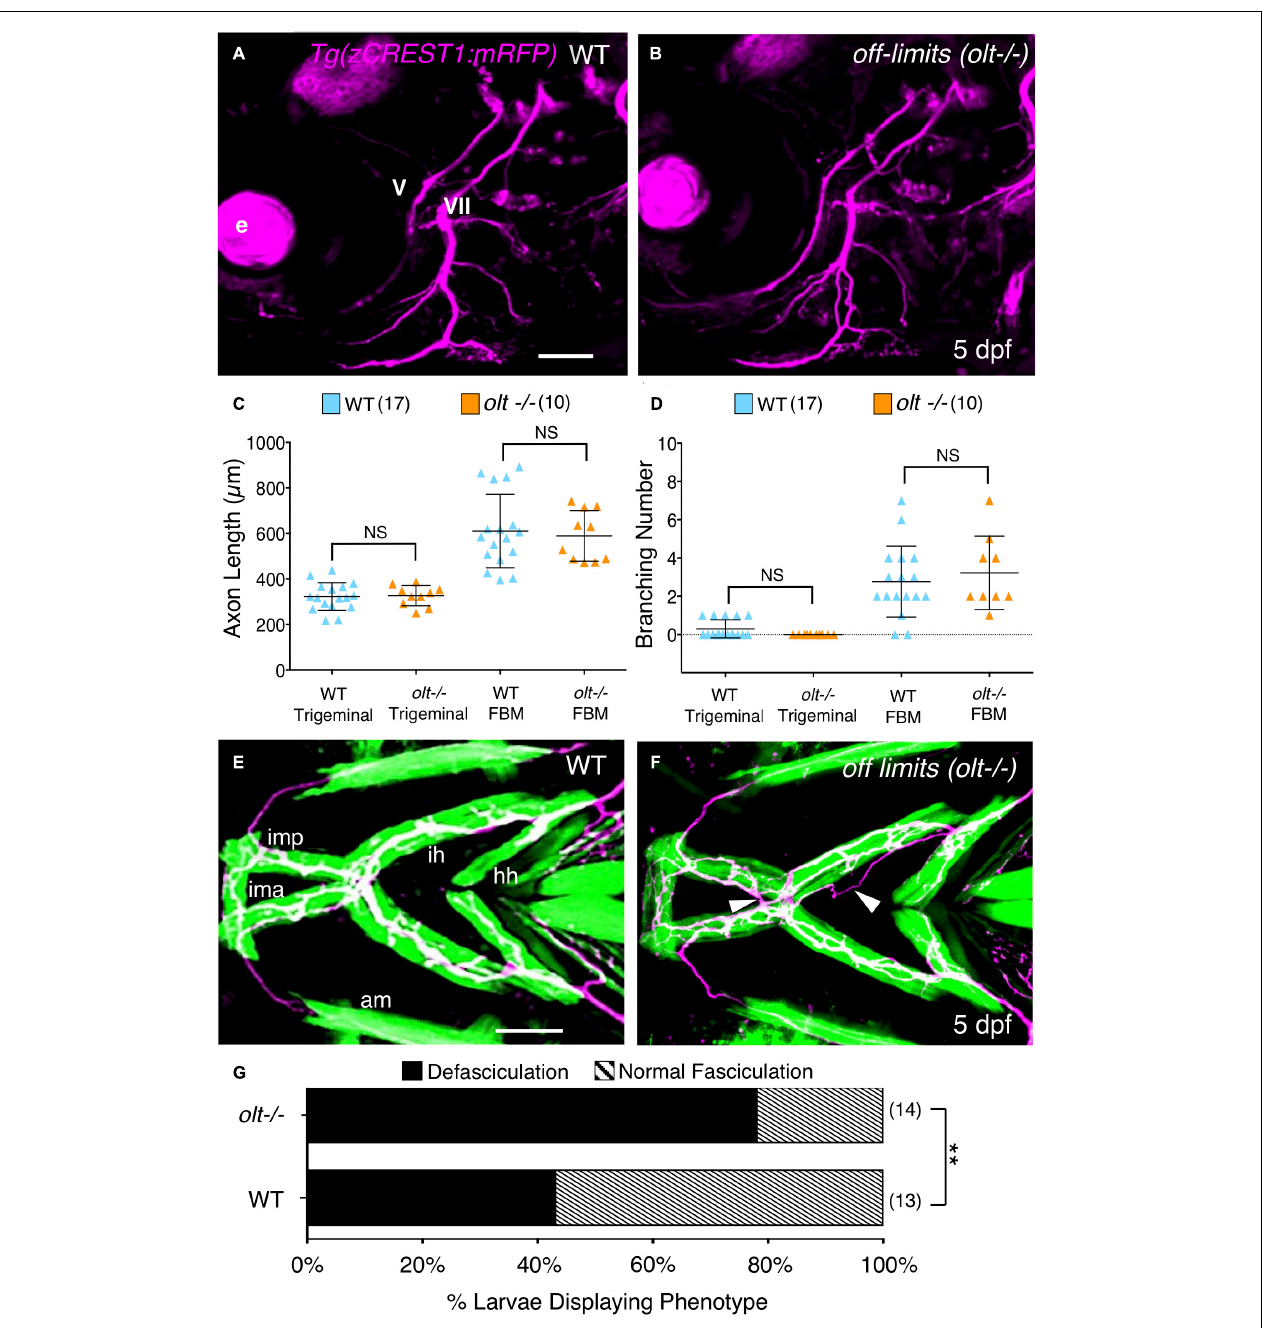
FIGURE 5 | Axon guidance and outgrowth are unaffected in olt mutant larvae. (A,B) Lateral view with anterior to the left of the hindbrains of 5 dpf Tg(zCREST1:mRFP) larvae. The morphologies of trigeminal (V) and FBM (VII) axons were analyzed and number of branches were calculated with Leica Application Suite X (LAS X) software. e, eye. (C) The total lengths of trigeminal motor axons and FBM axons and their branches were similar between olt mutants and wildtype siblings. (D) Trigeminal motor and FBM axon branching numbers showed no significant differences between wildtype siblings and olt mutants. Statistical analysis was performed with a two-tailed student t -test (C,D) . NS, not significant. Pooled data from 4 experiments (number of larvae in parenthesis). (E,F) Ventral view with anterior to the left of the jaw musculature in 5 dpf Tg(zCREST1:mRFP); Tg( α -actin:GFP) larvae showing motor axons (magenta) and jaw and gill muscles (green). (E) Thick motor axon fascicles were seen on the ima/imp, ih, and hh muscles in wildtype siblings. This phenotype was defined as Normal Fasciculation (NF). (F) In olt mutants, these axon fascicles appeared thinner and were frequently defasciculated (arrowheads), especially on the ih muscle. This phenotype was defined as Defasciculation (DF). (G) There was a preponderance of the defasciculated axon (DF) phenotype in olt mutants, and the proportion of normal fasciculation (NF) to defasciculated (DF) axons was significantly different between wildtype siblings and olt mutants. Statistical analysis was performed using Fisher’s two-tailed exact test. Data pooled from 4 experiments (number of larvae in parenthesis). ** p < 0.0001. ima/imp, intermandibularis anterior/intermandibularis posterior; ih, interhyal; hh, hyohal. Scale bar (A,E) , 100 µ m.